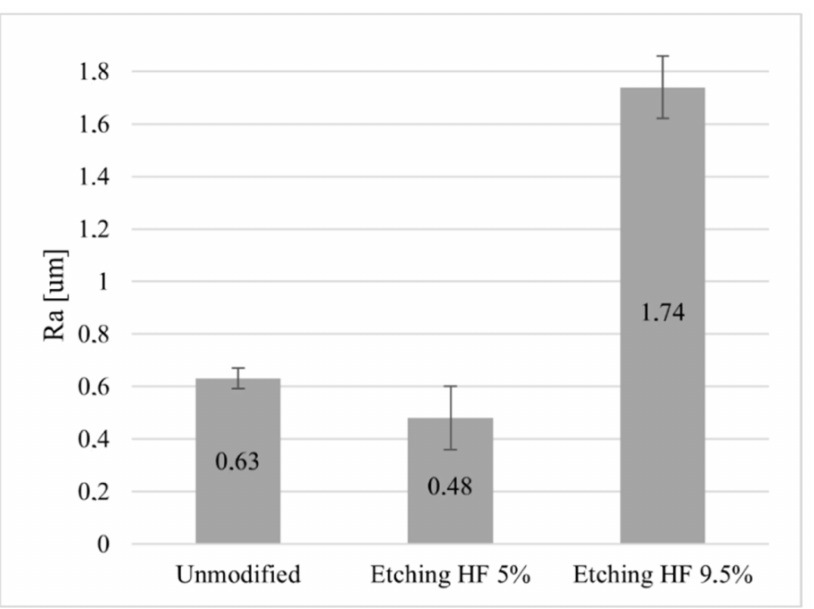
Figure 1. Change in Ra value of chemically modified Al 2 O 3 ceramic